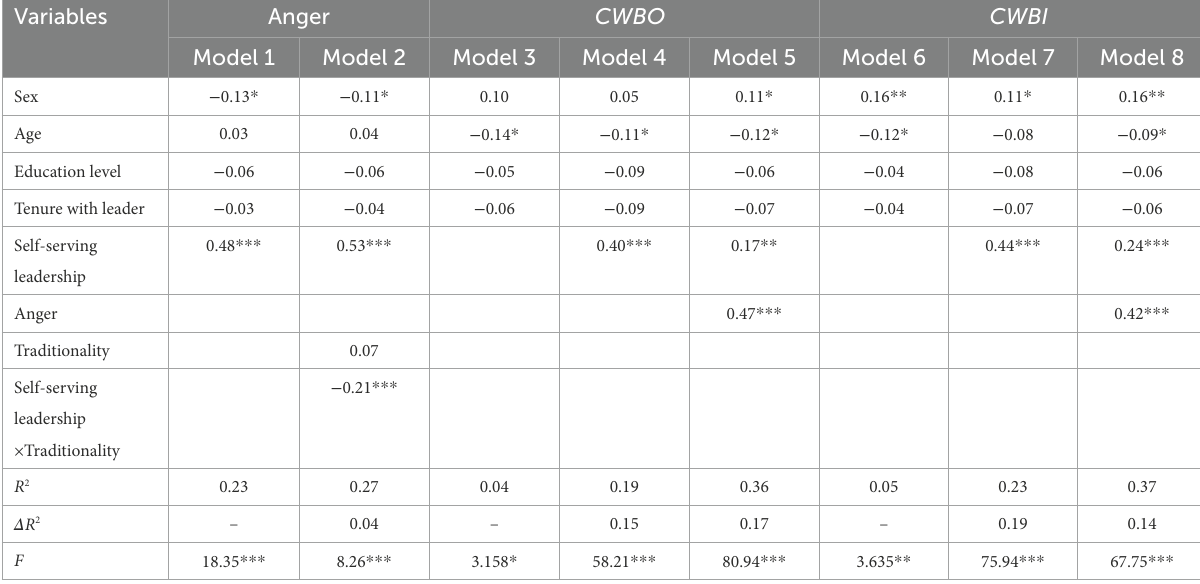
TABLE 3 Results of hierarchical regression analysis.